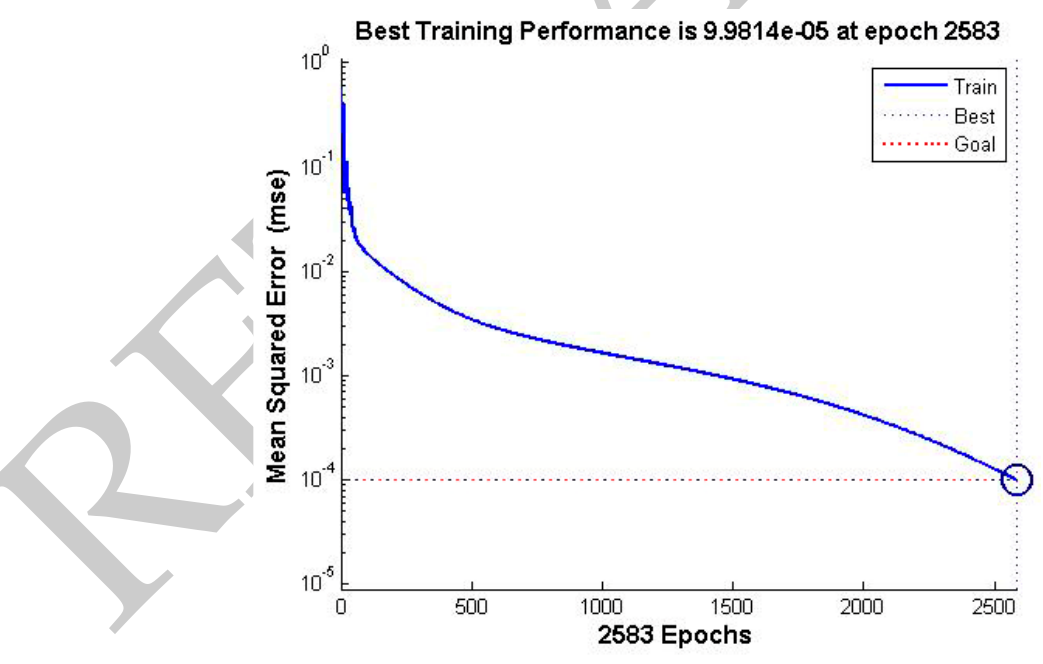
Figure 2. Effect of neural network training.